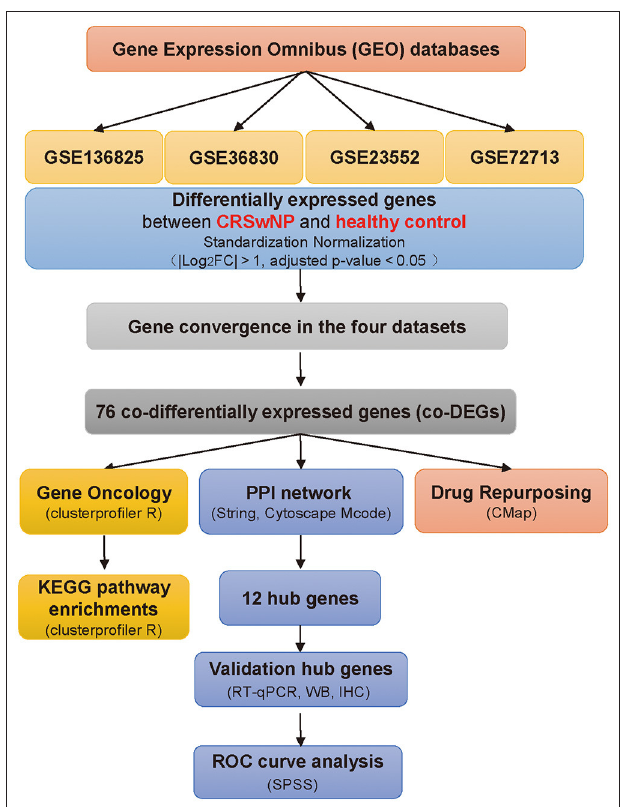
FIGURE 1 | Schematic overview of the study. Flowchart of the study to identify potential factors underlying CRSwNP pathogenesis compared with healthy controls. CRSwNP, chronic rhinosinusitis with nasal polyps; GO, Gene Ontology; FC, fold change; Gene Ontology; KEGG, Kyoto Encyclopedia of Genes and Genomes; PPI, protein-protein interaction; co-DEGs, co-differentially expressed genes; CMap, Connectivity Map database; RT-qPCR, real-time quantitative PCR; WB, western blot; IHC,